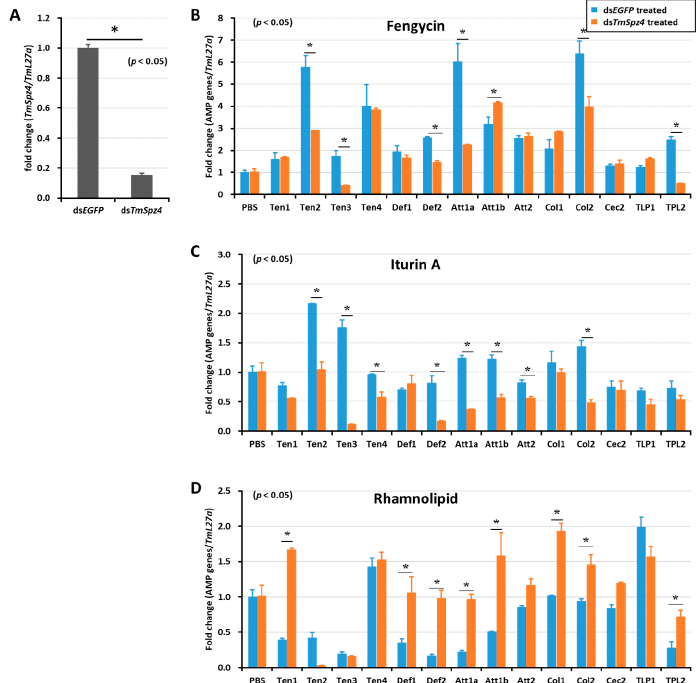
Figure 6. Effect of TmSpz 4 gene silencing on AMP induction in T. molitor larvae. The expression of TmSpz 4 was silenced ( A ), then either fengycin ( B ), iturin A ( C ), or rhamnolipid ( D ) was injected into the gene-silenced larvae. Whole-body AMP expression was examined after 9 h post biosurfactant injection. The expression of AMPs in each tissue was quantified by qRT-PCR, using specific primers. The data are the mean of three individual replicates. * significant di ff erence ( p < 0.05) in AMP expression, compared to the ds EGFP -injected